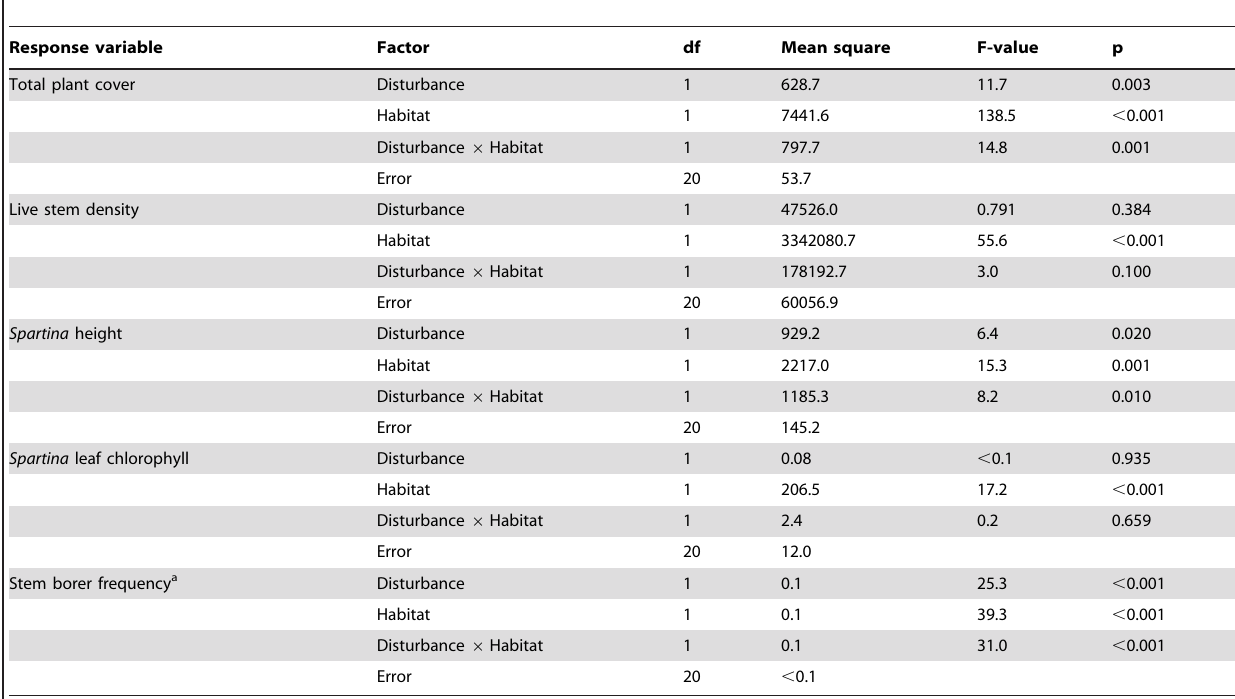
Table 1. Summary of two-way ANOVA results for plant and stem borer responses to plant removal disturbance treatments in mound (small patch) and terrace (large patch)